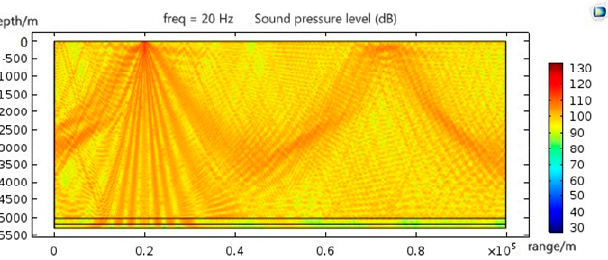
Figure 9. Sound pressure level (dB) distribution when there is no vortex (DC = 0).